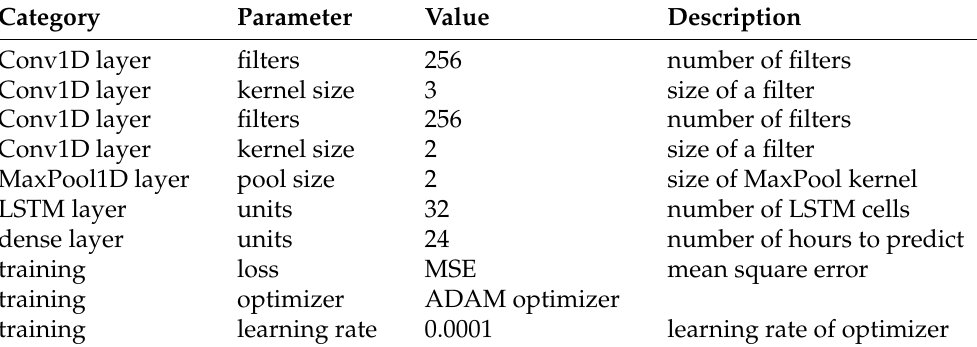
Table A4. Architecture of the convolutional LSTM network.